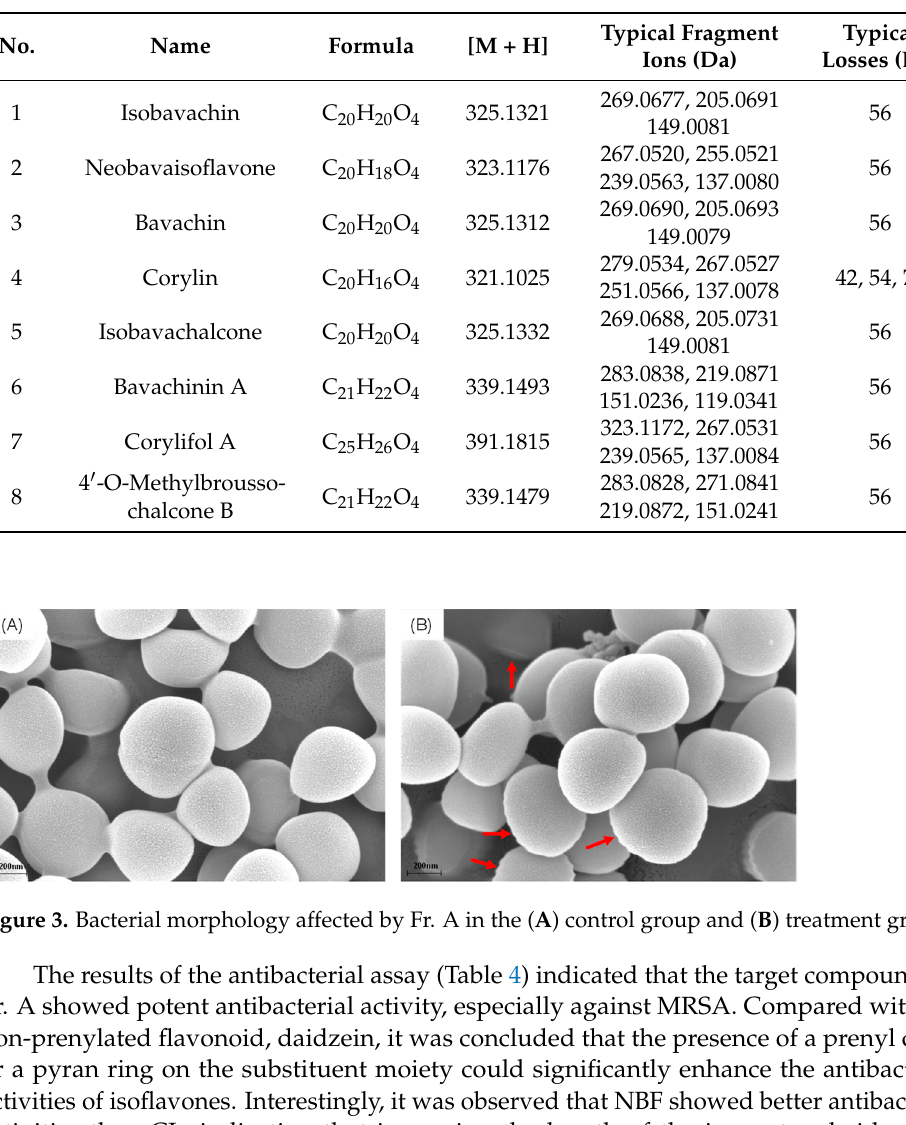
Table 3. The MS data of the prenylated flavonoids in Fr. A.